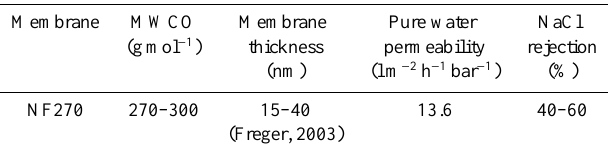
Table 1. Selected properties for the virgin NF270